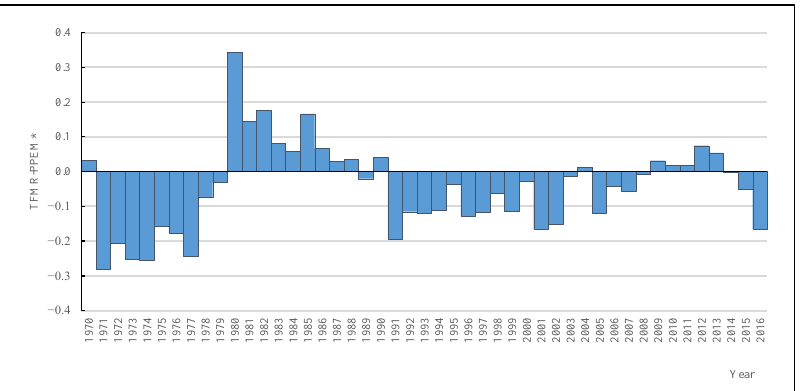
Figure 3. The tempo effects of Chinese women, 1970–2016. Source: 2005 China 1% Population Sample Survey and the 2017 China Fertility Sample Survey.